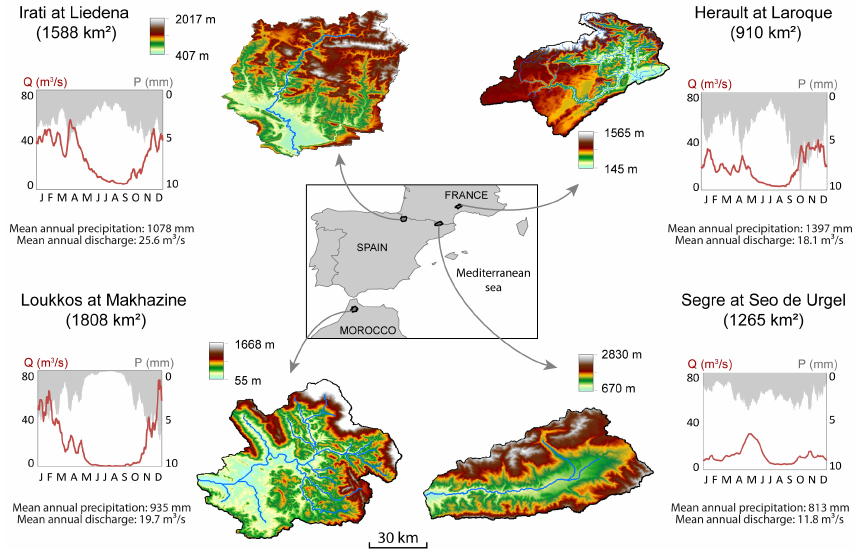
Figure 1. Study catchments (Herault, Segre, Irati and Loukkos) in the western Mediterranean region with their topography and mean seasonal variability in precipitation ( P ) and discharge ( Q ) for the period